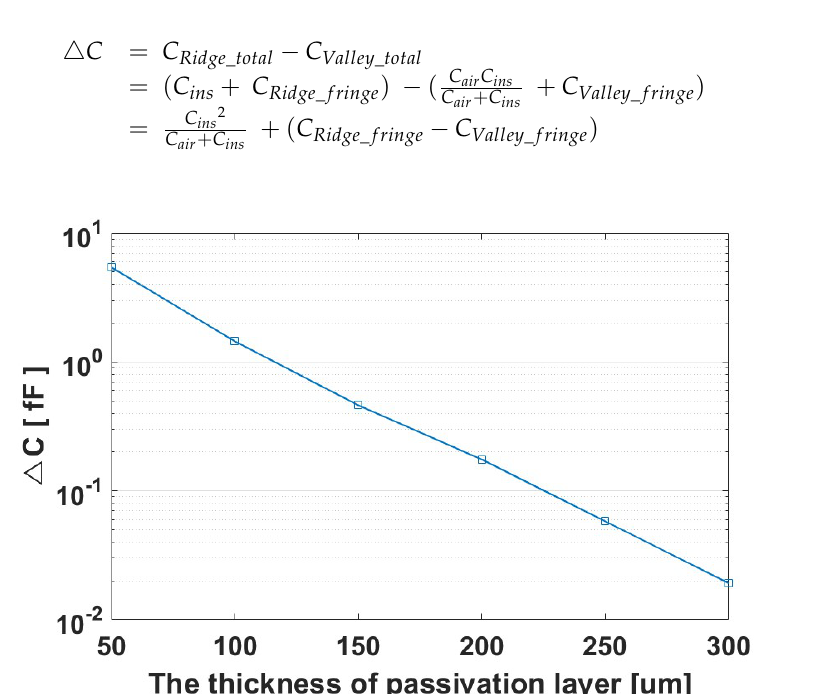
Figure 2. Δ C vs. the thickness of the passivation layer.